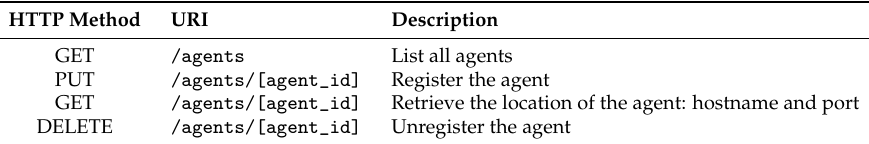
Table 5. Discovery